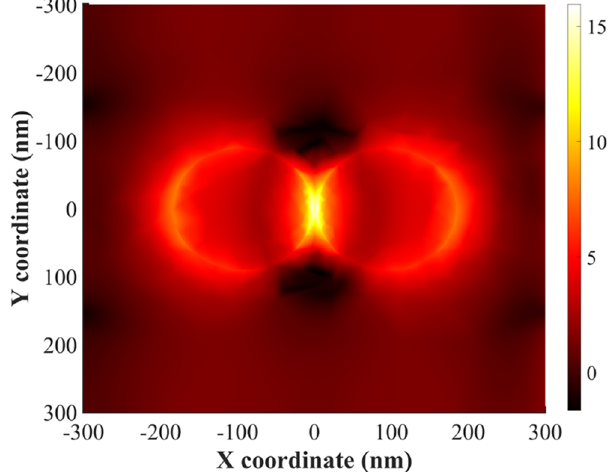
Fig. 5. Distribution of the SECARS enhancement factor ; l 1 ; l 1 Þ across the unit cell directly above the G D 1 ð ~ r ; l 1 log 10 p a S nanodisk top surface.